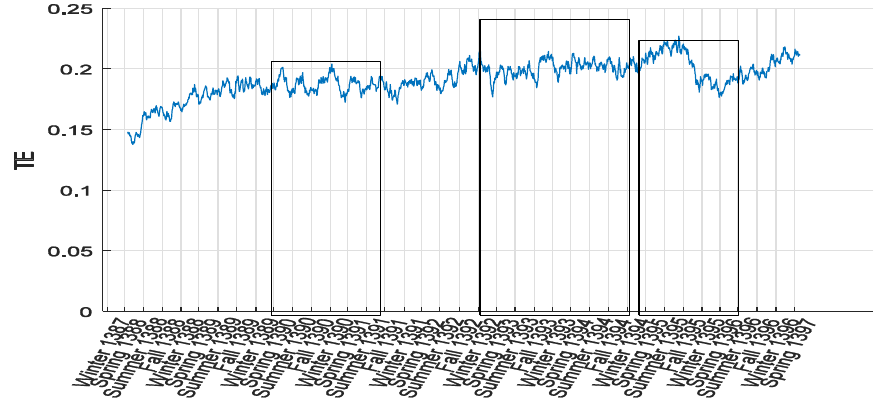
Figure 9. The average transfer entropy per 180 companies on the Tehran Stock